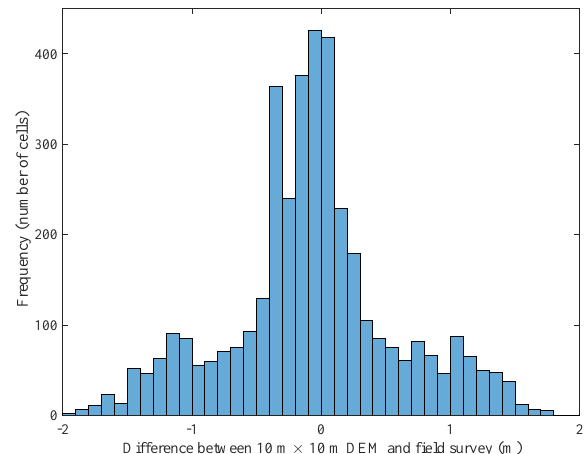
Figure 4. Elevation difference between the topography from field measurement and the resampled 2m × 2m DEM used for hydraulic